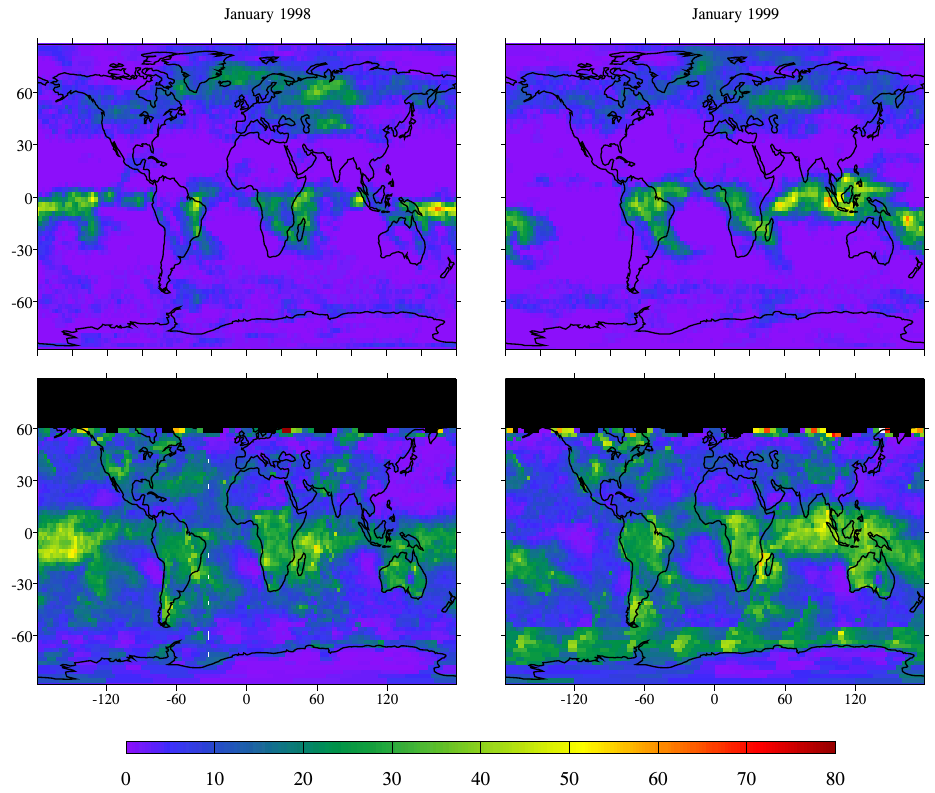
Fig. 3. Comparison of the frequency of occurrence of ice (units are %) between that diagnosed by the model (top row) and values from the International Satellite Cloud Climatology Project (ISCCP) (bottom row). These are both monthly mean values for January 1998 (left column) and 1999 (right column). The model data is for all time samples whereas the ISCCP data is for daytime only with the black areas within the ISCCP plots indicating missing data associated with the polar night. Comparison between model and the ISCCP figures show similar frequencies of occurrence and spatial distribution in the